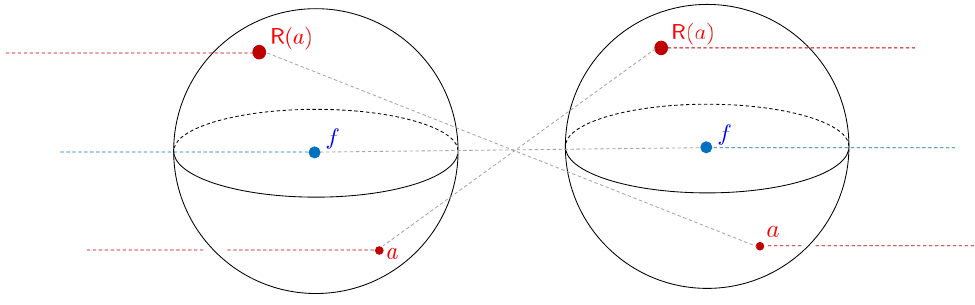
Figure 6 . Con(cid:12)guration of anyons on the cut section D 3 . The antipodal map of D 3 acts on the state with particles a; R ( a ) ; f